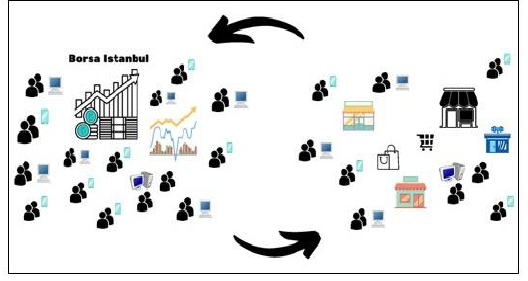
Figure 4. Proposal Model Section